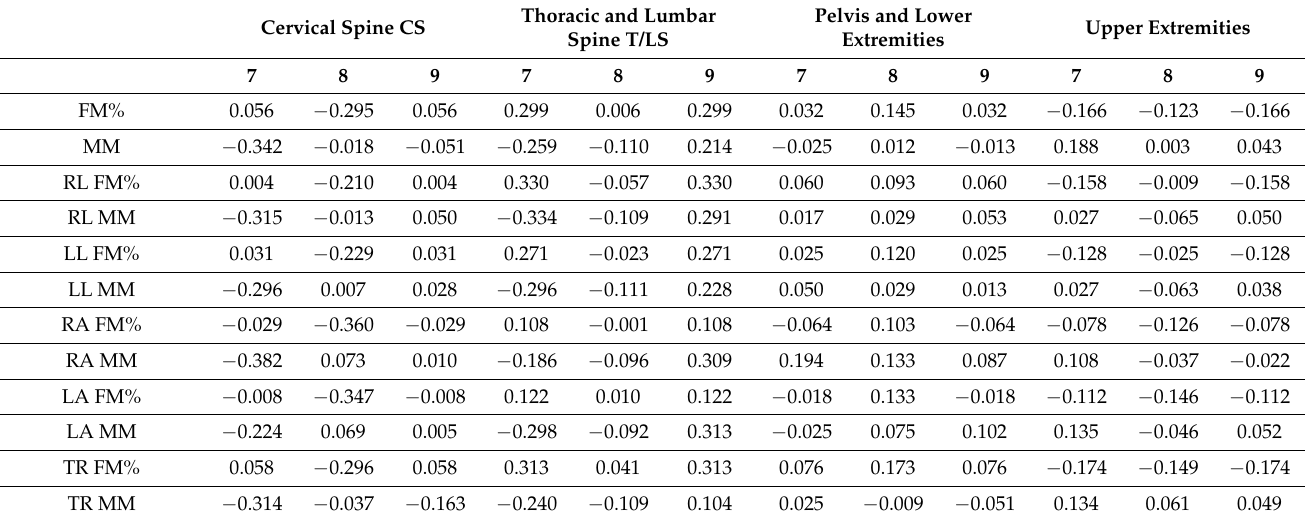
Table 4. Correlation between the general and segmental body composition and the incidence of body posture abnormalities in individual age groups.